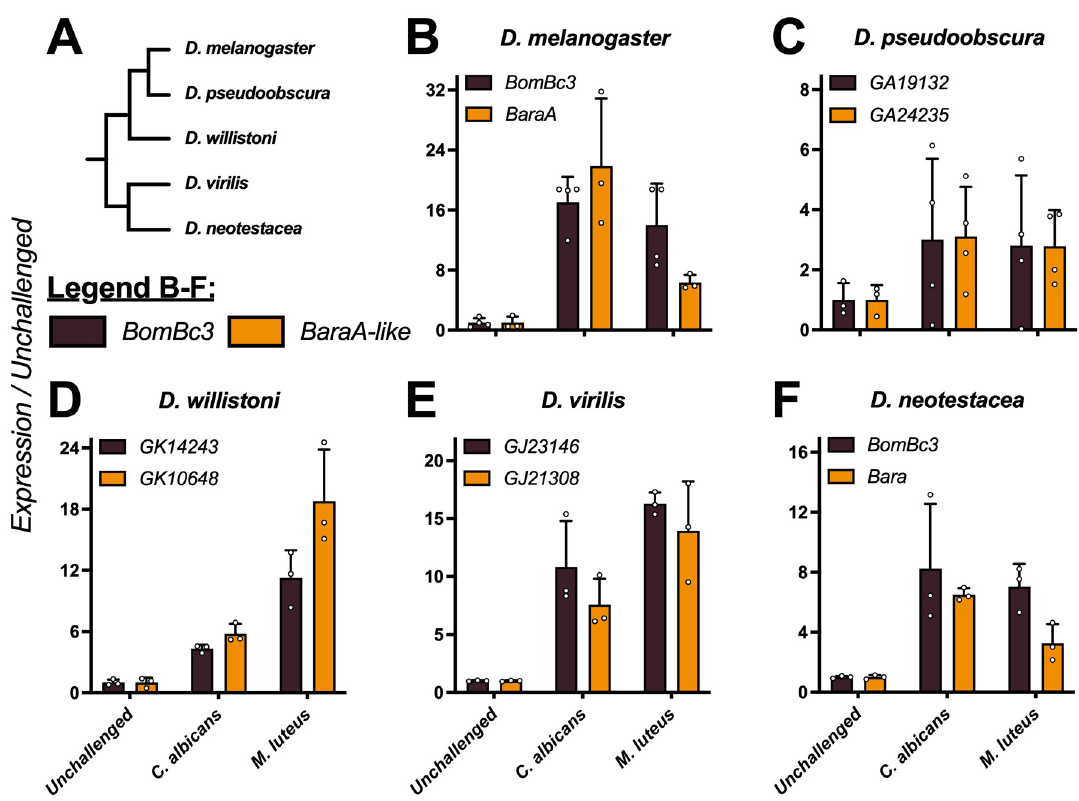
Fig 1. The ancestral BaraA gene was immune-induced. A) Cladogram of species used in B-F. B-F) Expression of the Toll-responsive gene BomBc3 (brown) or BaraA-like genes (orange) in diverse Drosophila species upon infection. In all cases, both BomBc3 and BaraA- like genes are induced upon infection by either C . albicans yeast or M . luteus bacteria.